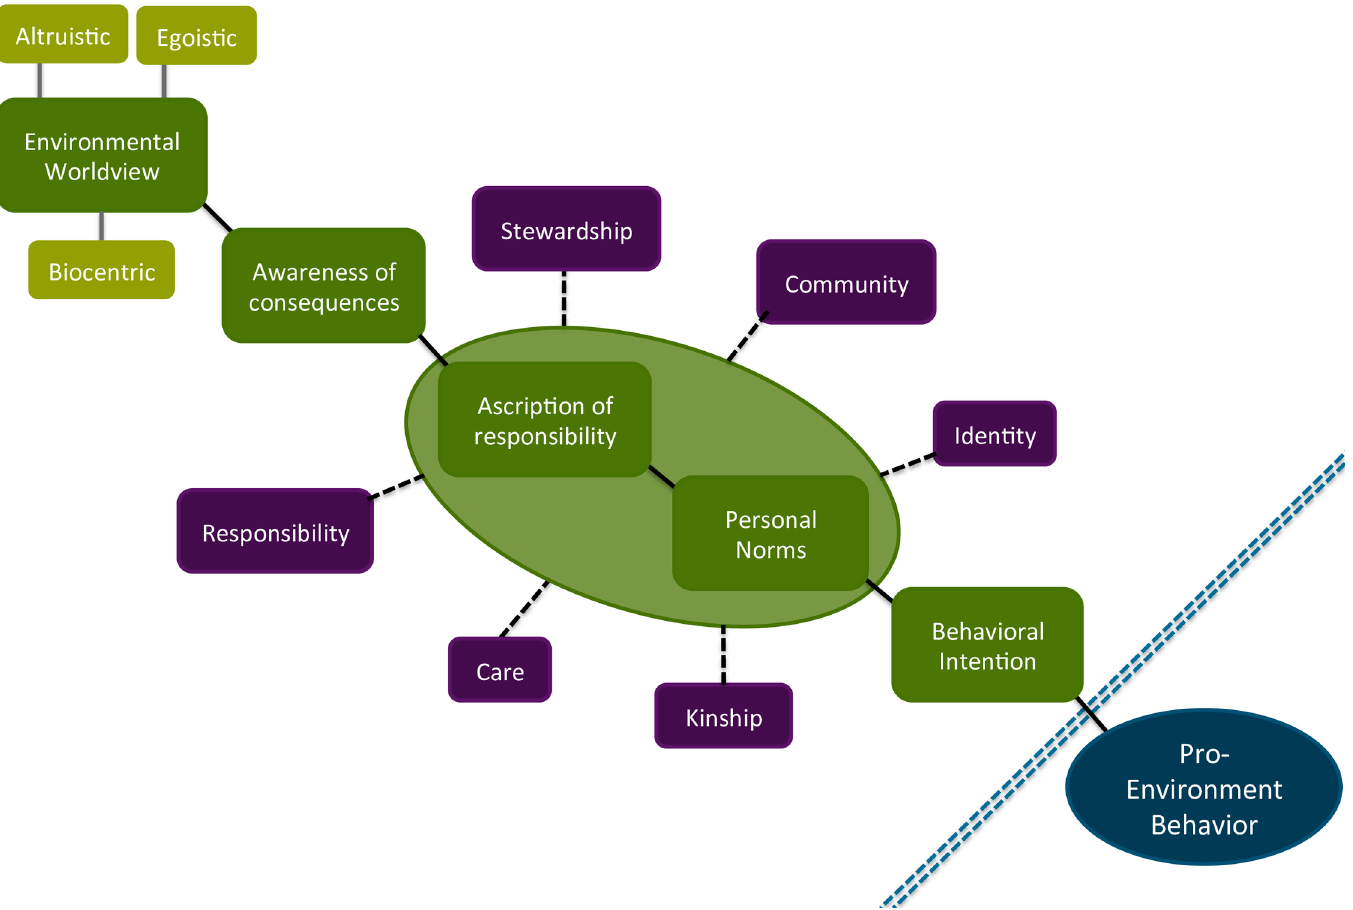
Fig 4. Value-belief norm model (green) with our proposed ways in which relational framings (purple) could influence steps of this pathway (black dashes). We acknowledgethe variety of barriers betweenbehavioral intention and pro-environment behavior(dashedblue